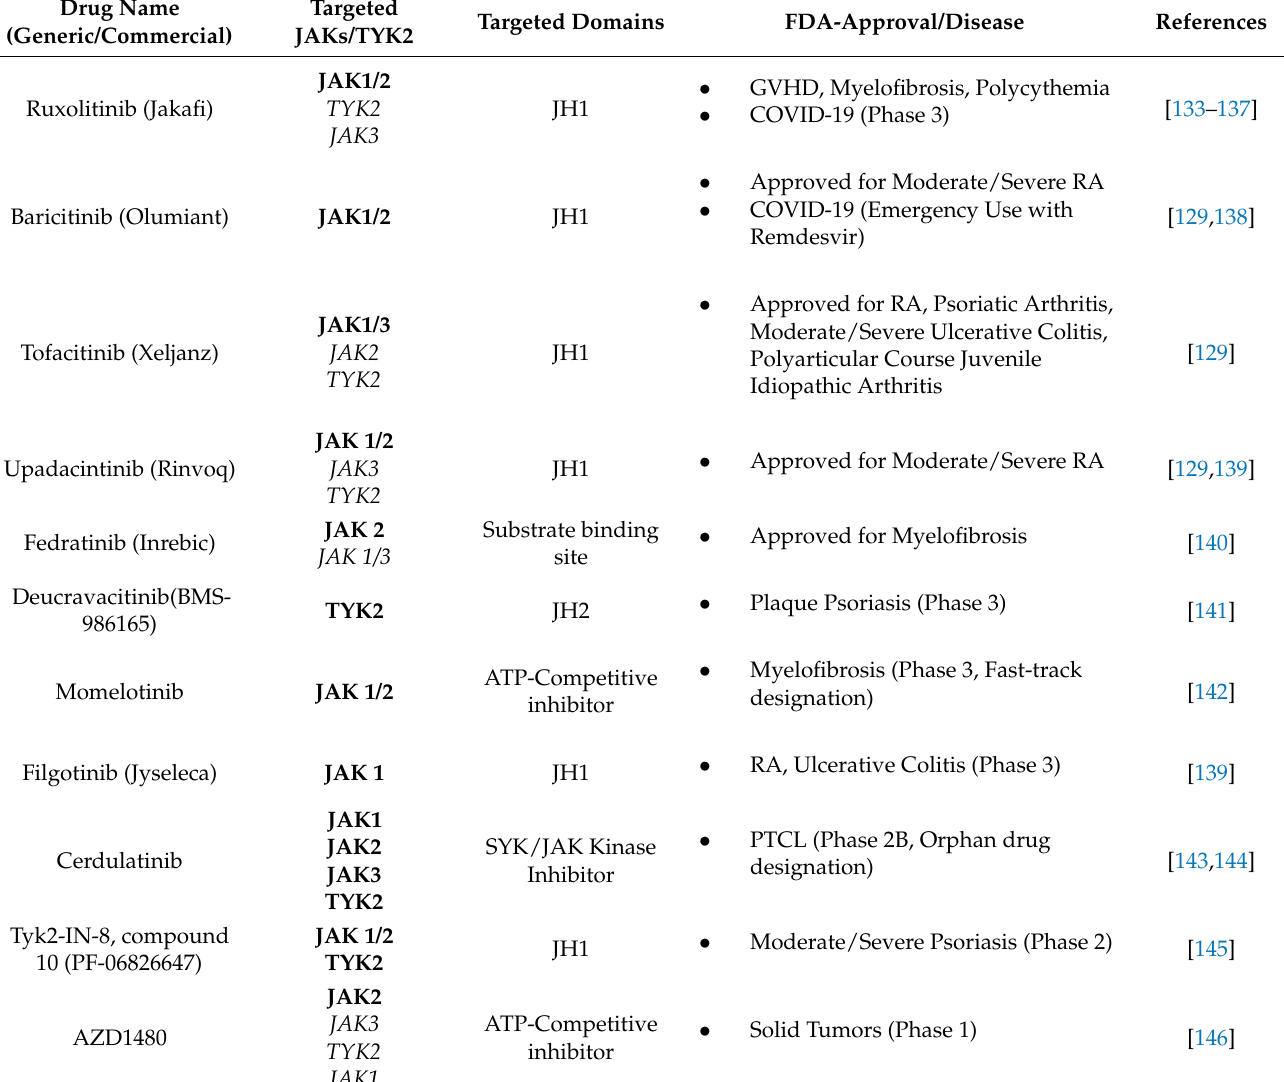
Table 2. Pharmacologic Inhibitors of JAKs/TYK2 (FDA-approved/In Clinical